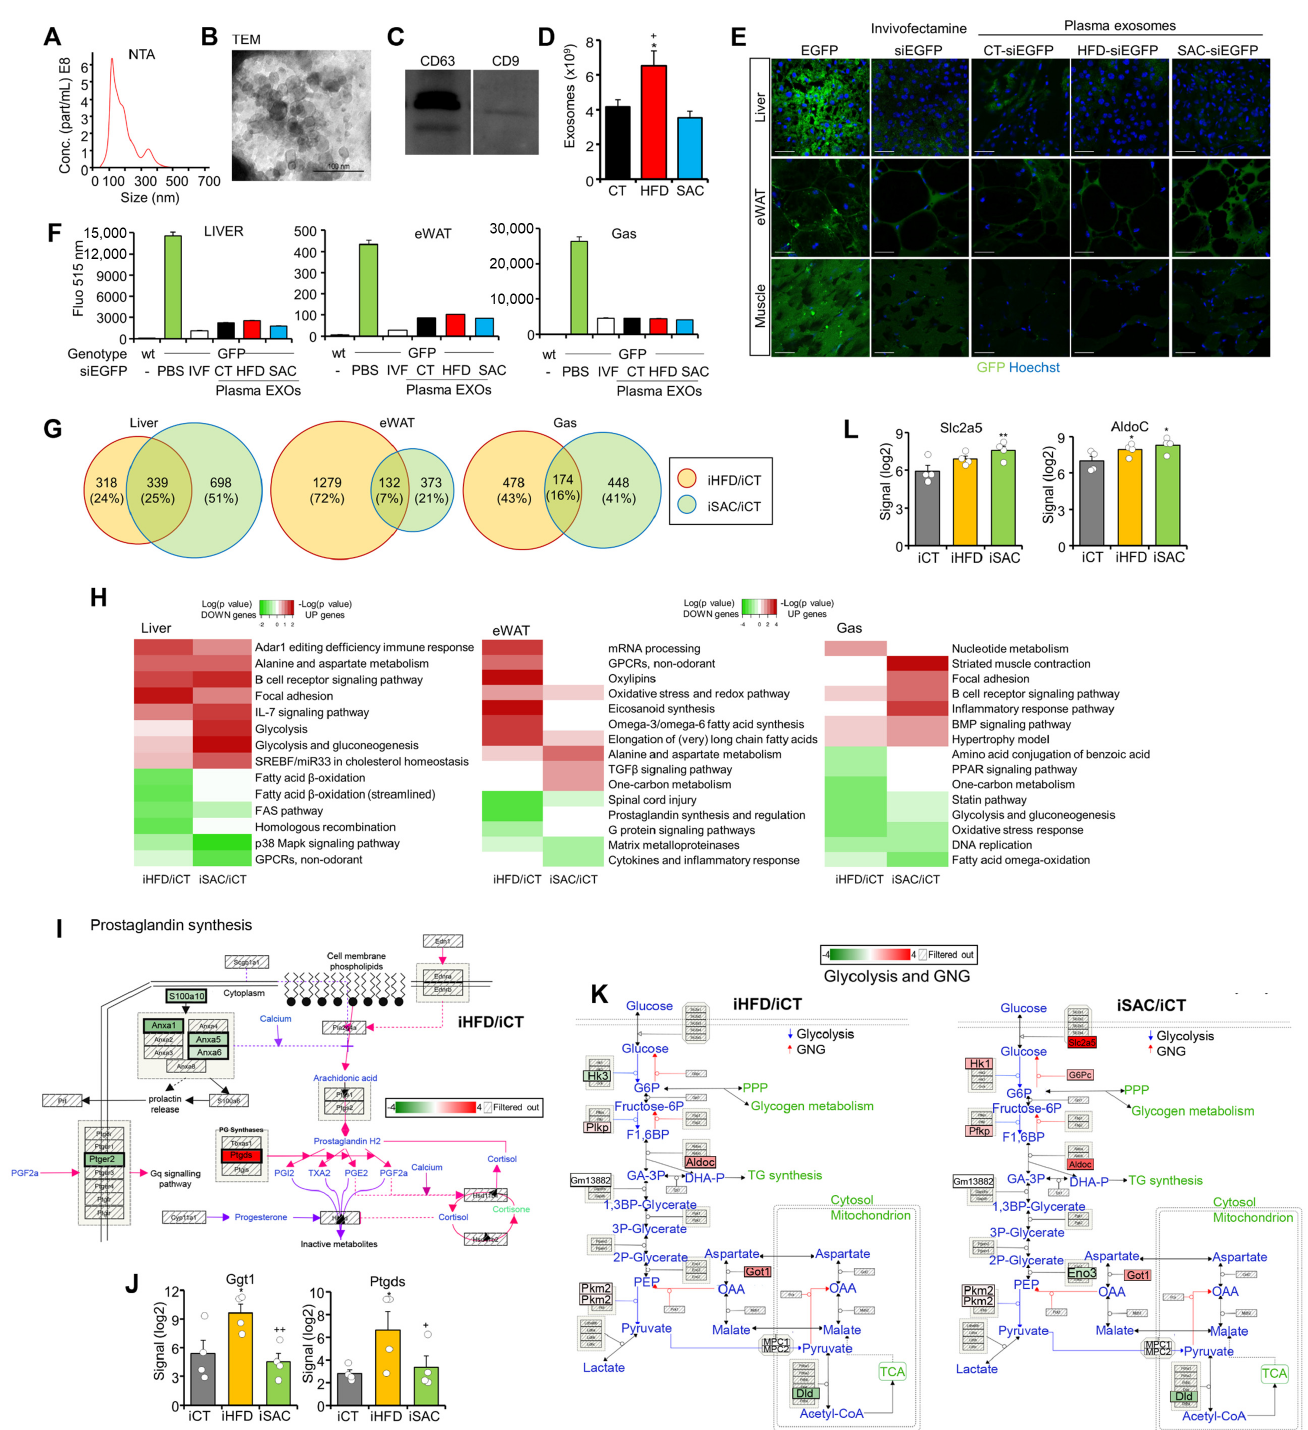
Figure 4. Injection of HFD and SAC plasma exosomes reproduce transcriptomic changes observed in donor mice. ( A – D ): Plasma exosomes from donor mice were characterized by NTA ( A ), TEM ( B ), Western blotting of membrane markers CD63 and CD9 ( C ), and exosome number ( D ). ( E , F ): Biodistribution of plasma exosomes from CT, HFD, and SAC mice was followed by transfecting them with a siRNA against EGFP and IV injection into EGFP transgenic mice. Injection of the same siEGFP associated with Invivofectamine was used as a positive control. Loss of fluorescence was determined using confocal microscopy of the tissues of interest ( E ) and luminometer analysis of tissue lysates ( F